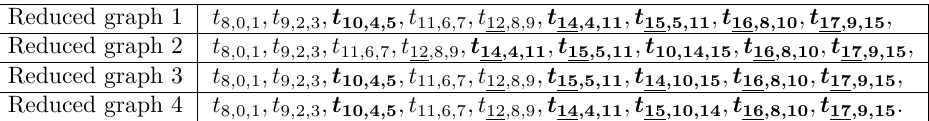
Table 8: The reduced